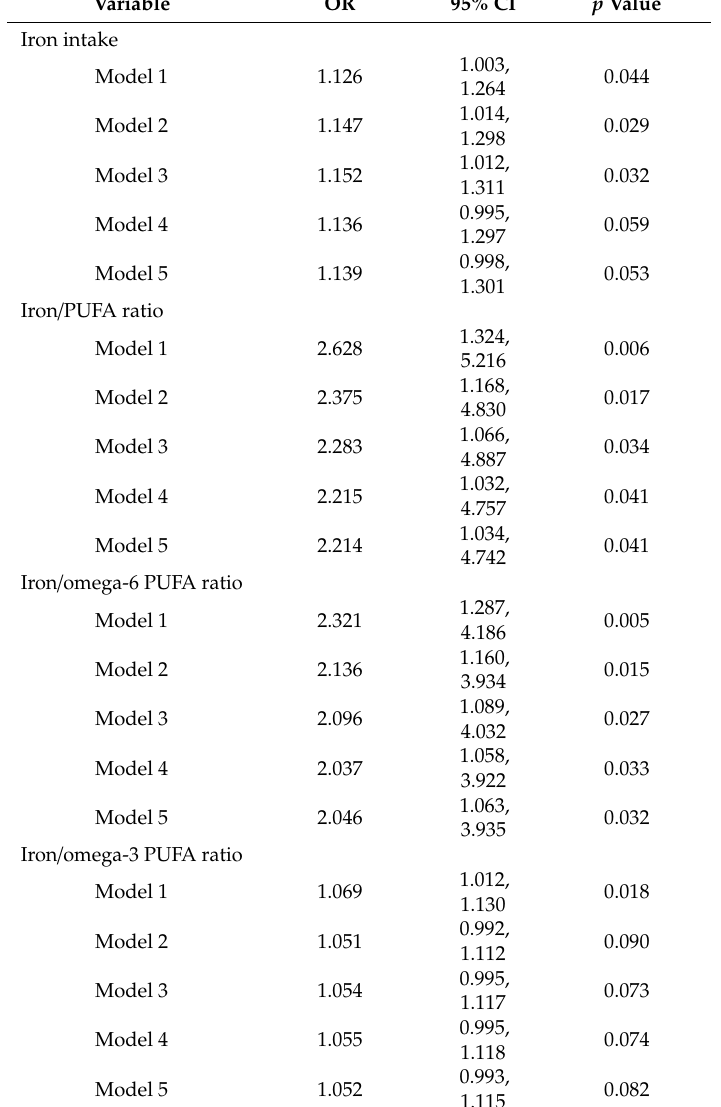
Table 4. Odds ratios (ORs, 95% CI) between iron intake, iron / PUFA, and